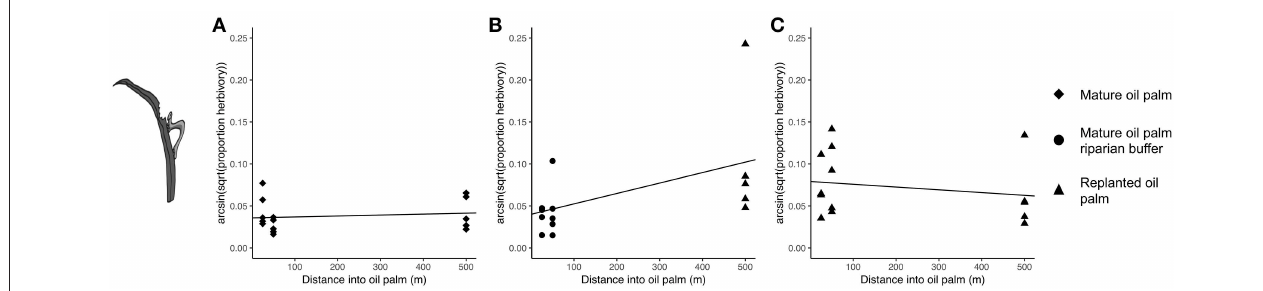
FIGURE 3 | Plot of the best-fitting model for herbivory: Transformed_Herbivory ∼ Vegetation Type * Distance + (1|Site). The herbivory data has been arcsine square-root transformed. Point shape denotes vegetation type. (A) Mature oil palm; (B) Replanted oil palm with a mature oil palm riparian buffer; and (C) Replanted oil